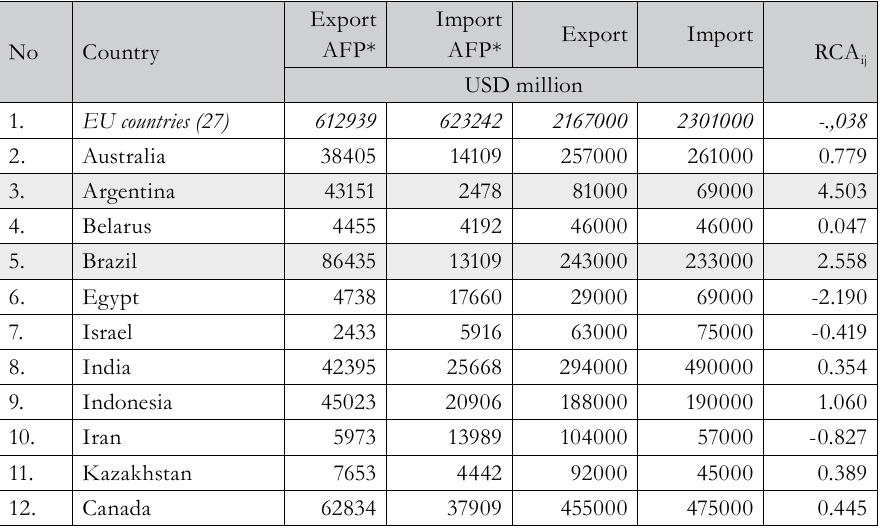
Tab. 2 – Calculation of actual comparative advantages of separate countries of the world in agri-food products foreign trade, 2017. Source: compiled by the author on the basis of